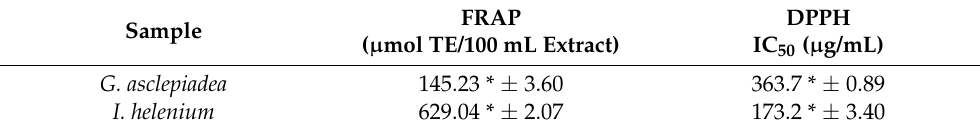
Table 3. Antioxidant capacity of G. asclepiadea and I. helenium root ethanolic extracts.